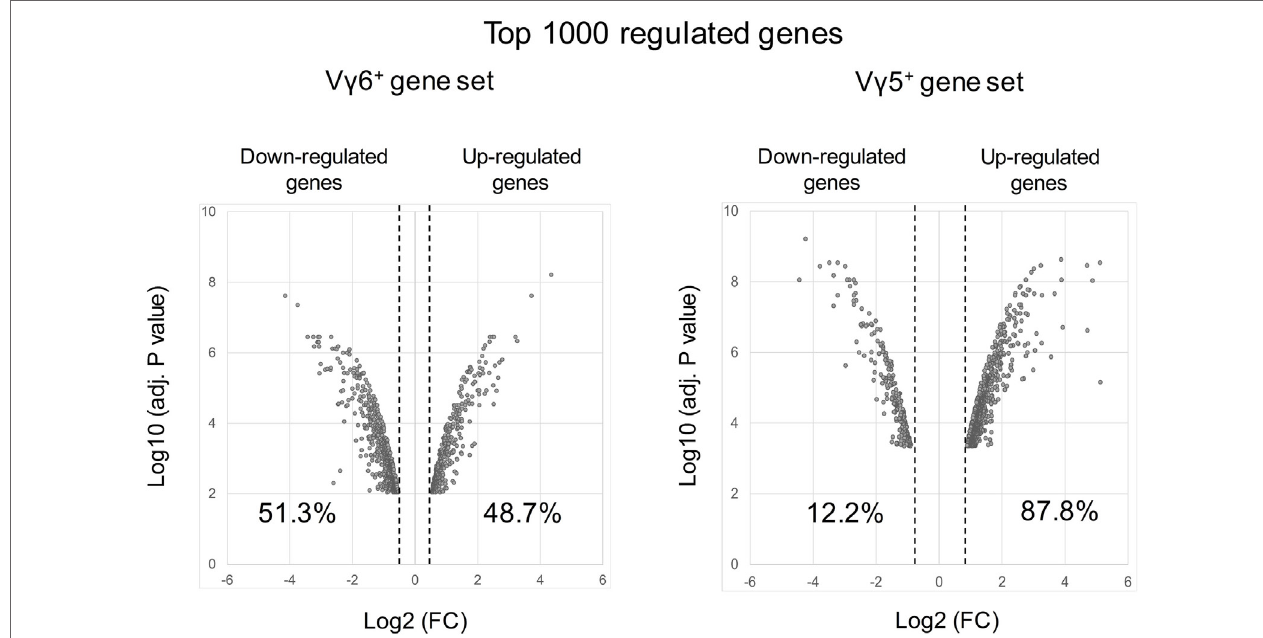
FiguRe 3 | Volcano plots of the top 1,000 regulated genes during V γ 6 and V γ 5 maturation. Raw data were extracted from datasets (GSE37448 and GSE15907) downloaded from the NCBI’s data repositories. V γ 6 + and V γ 5 + gene sets were generated by comparing gene expression in immature (CD24 high ) vs mature (CD24 low ) thymocytes at E17 for both populations (2–3 replicates/subset). The top 1,000 regulated genes ( P < 0.05) were used to constitute the two gene sets (Table S1 in Supplementary Material). Volcano plots represent either positively or negatively regulated genes (as fold change) according to their respective P value. Labels indicate the percentage of genes that are either positively or negatively regulated in each dataset. FC, fold